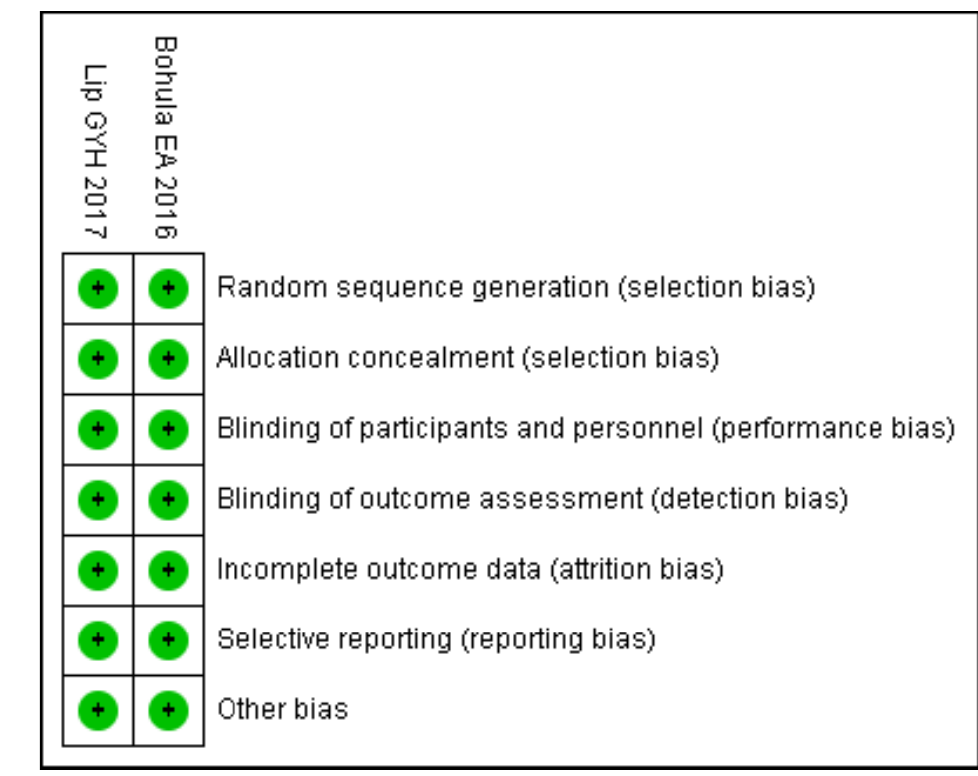
Figure 3. Risk of bias graph of each RCT appraised by Revman 5.3. Table 1. Summary of the retrieved articles on edoxaban versus warfarin among AF patients in rela- tion to CrCl.